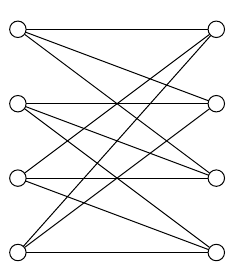
Figure 4. The graph F 4